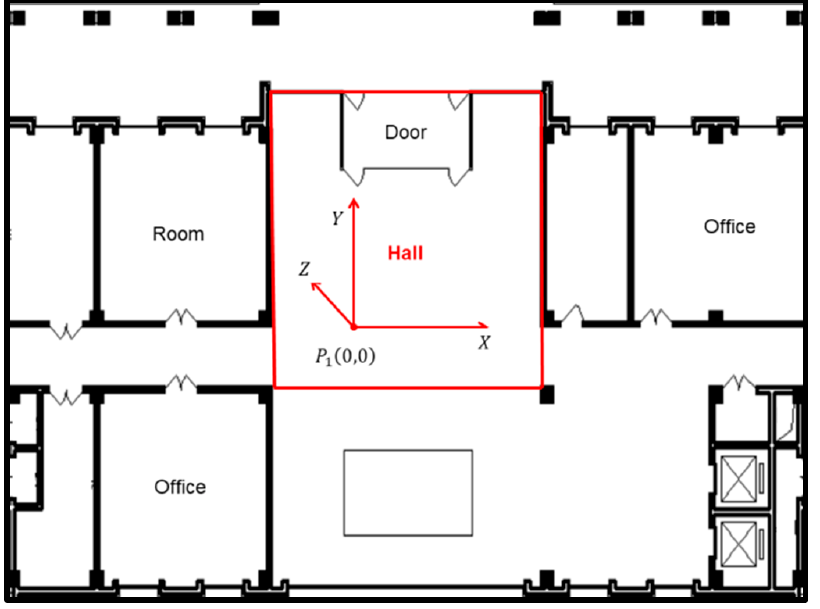
Figure 10. Experimental environment.